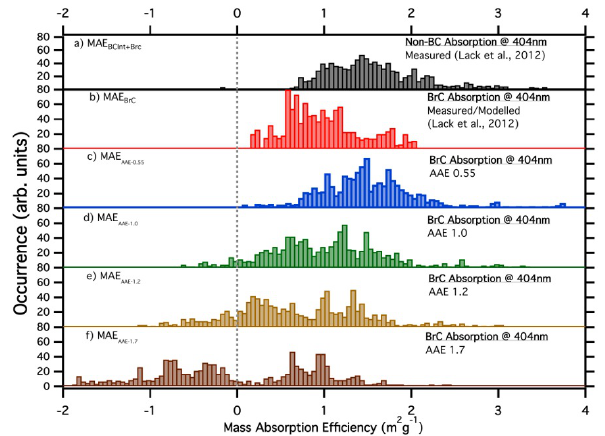
Fig. 4. Histograms of measured and calculated mass absorption ef- ficiency of NR-PM. (a) MAE BCInt + BrC : measured MAE includ- ing internal mixing and BrC, (b) MAE BrC : MAE of just BrC from Lack et al. (2012), and the MAE of BrC using the AAE attribution method using (c) AAE = 0.55, (d) AAE = 1.0, (e) AAE = 1.2, and (f) AAE =